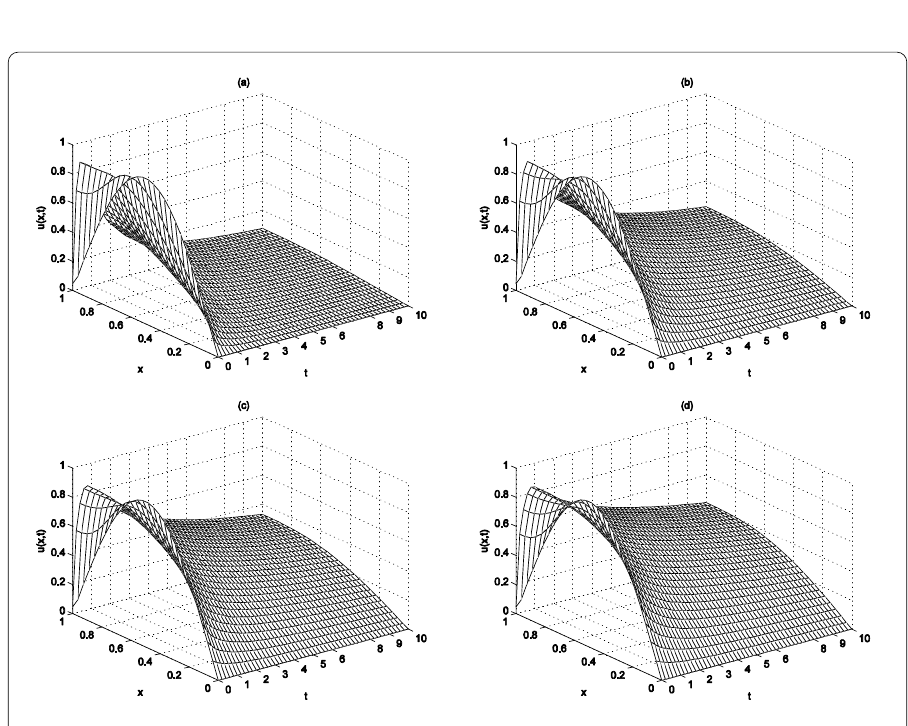
Figure 13 A 3-d landscape of the dynamics of the MGKdVB equation without control; v = 0.01, μ = 0.001, γ 1 = 1, γ 2 = 0.0005 and u 0 ( x ) = sin( π x ); ( a ) α = 1; ( b ) α = 2; ( c ) α = 3; ( d ) α = 4